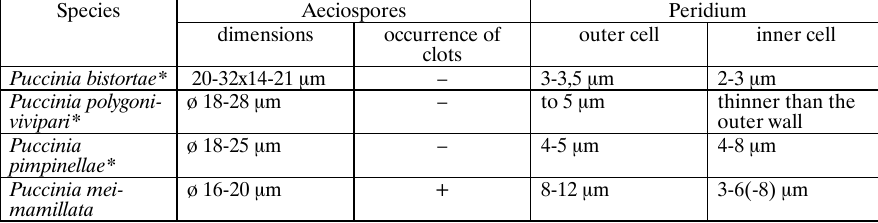
comparison of aecia of rust fungi occurring on Angelica spp. in